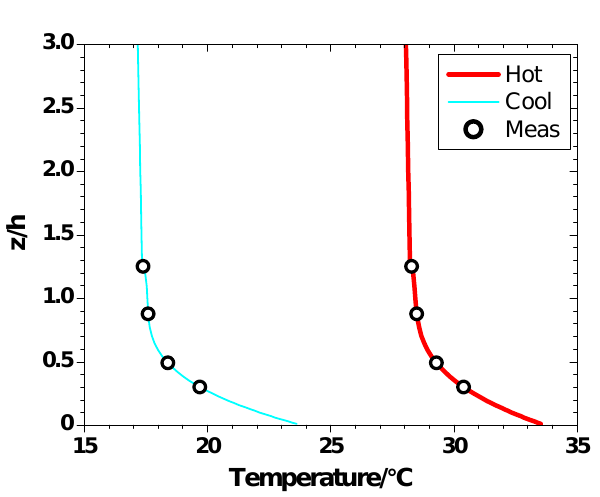
Fig. 1. Measured (open circles) and model-parameterized (solid lines) near-surface temperature profiles for the hot and cool